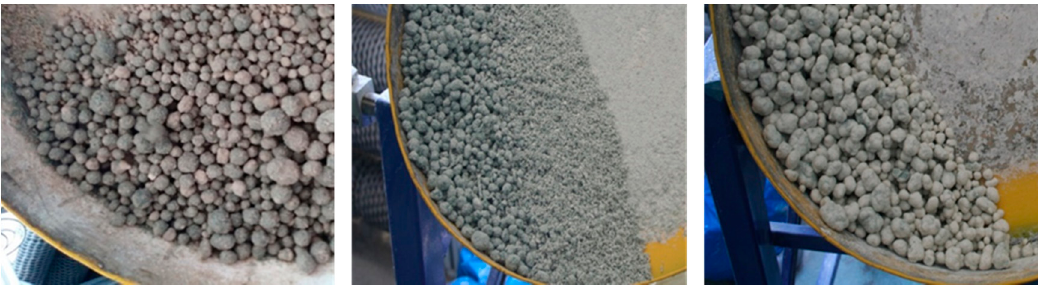
Figure 2. The process of granulation of tanning shavings in pulp according to methods 2, 4, and 7.